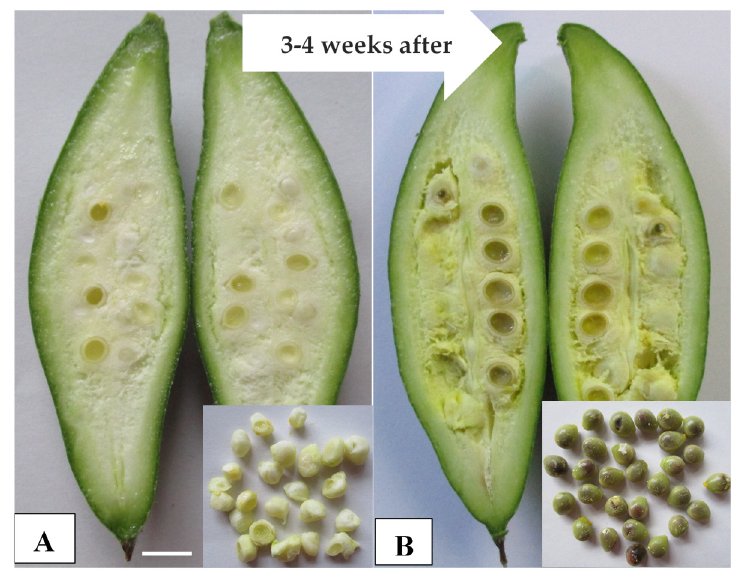
Figure 1. Fruits at the edible stage with soft-coated seeds ( A ) and hard-coated seeds ( B ). The bar indicates 1 cm.